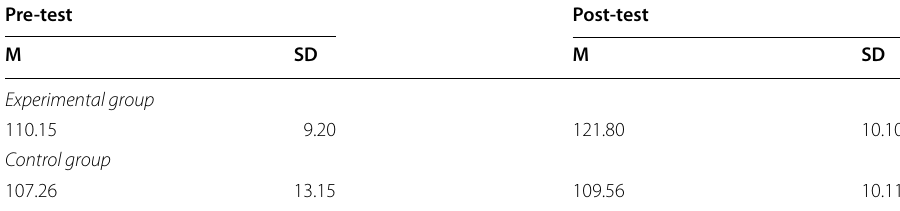
Table 11 Test scores using the Cambridge English Scale Pre-test